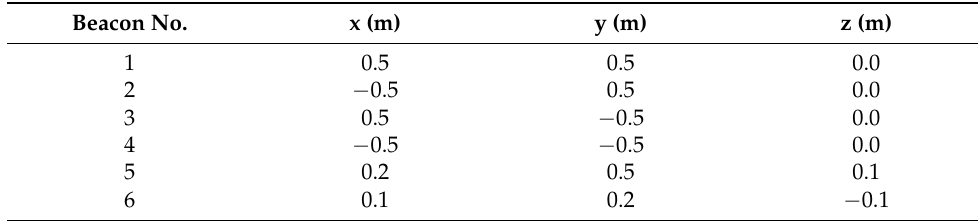
Table 1. Installation positions of beacons.